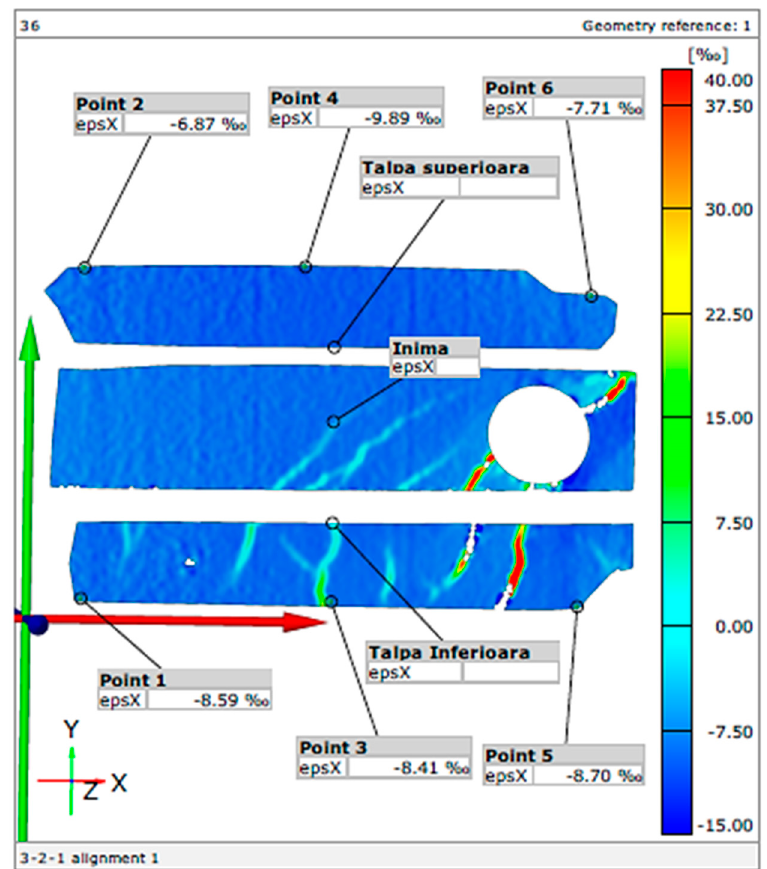
Figure 11. Experimental strains measured using the digital image correlation technique for limestone beam (GR-3-FC).